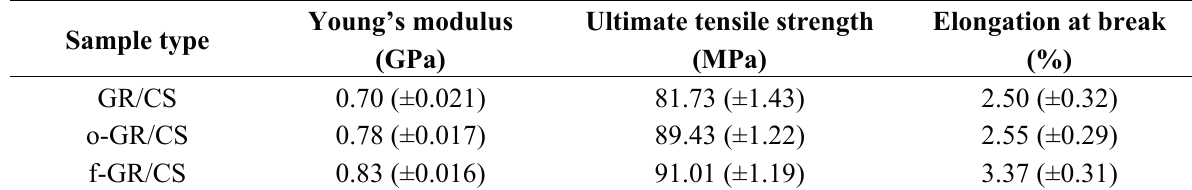
Figure 4. Comparison of the tensile strength and elastic modulus among GR/CS, o-GR/CS and f-GR/CS composite films. Table 1. Comparison of the tensile properties among graphene, o-graphene and f-graphene/chitosan composite films with averaged best value results.